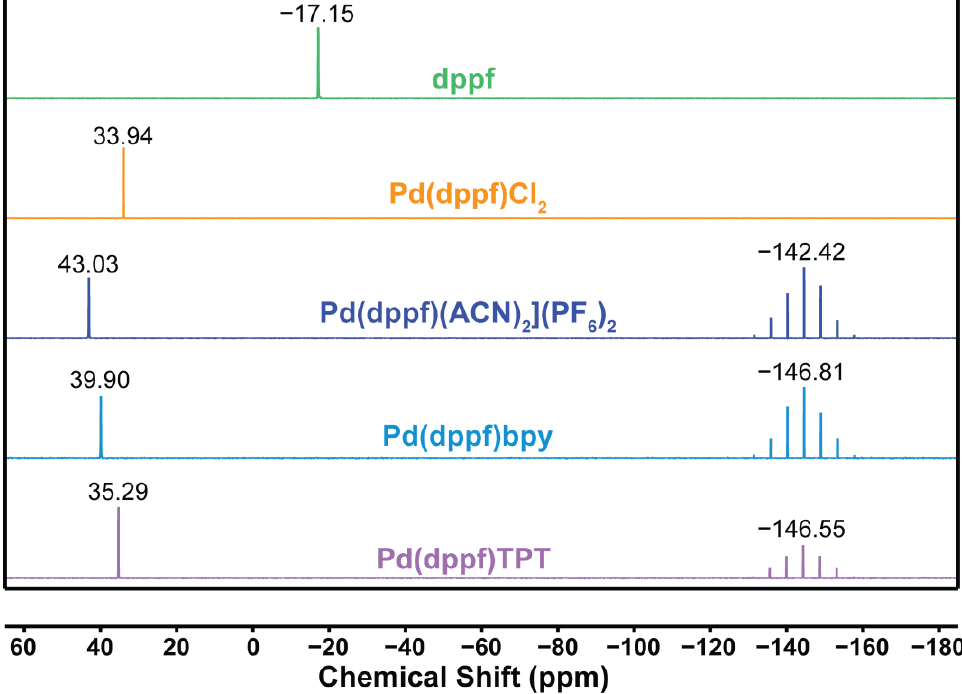
Figure 1. 31 P{ 1 H}-NMR spectra of Fc-containing compounds in D 2 -DCM. Each spectrum has been normalized to its respective singlet peak.